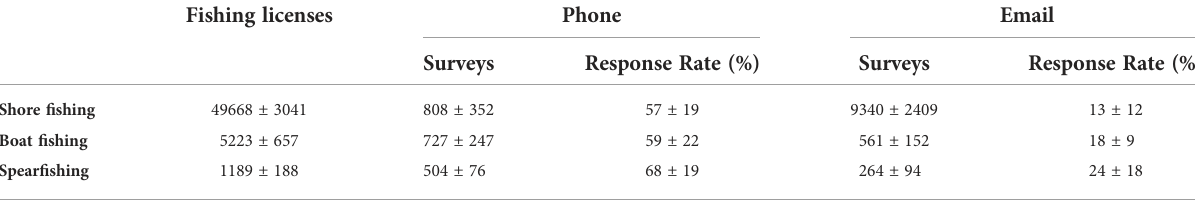
TABLE 1 Means ( ± SD, Standard Deviation) of the number of fi shers (i.e., licenses), conducted surveys (i.e., gross sample) by phone and email during the sampling period (2015 – 2019), and of the total response rates obtained (absolute numbers and percentages), for each fi shing mode. Fishing licenses Phone Email